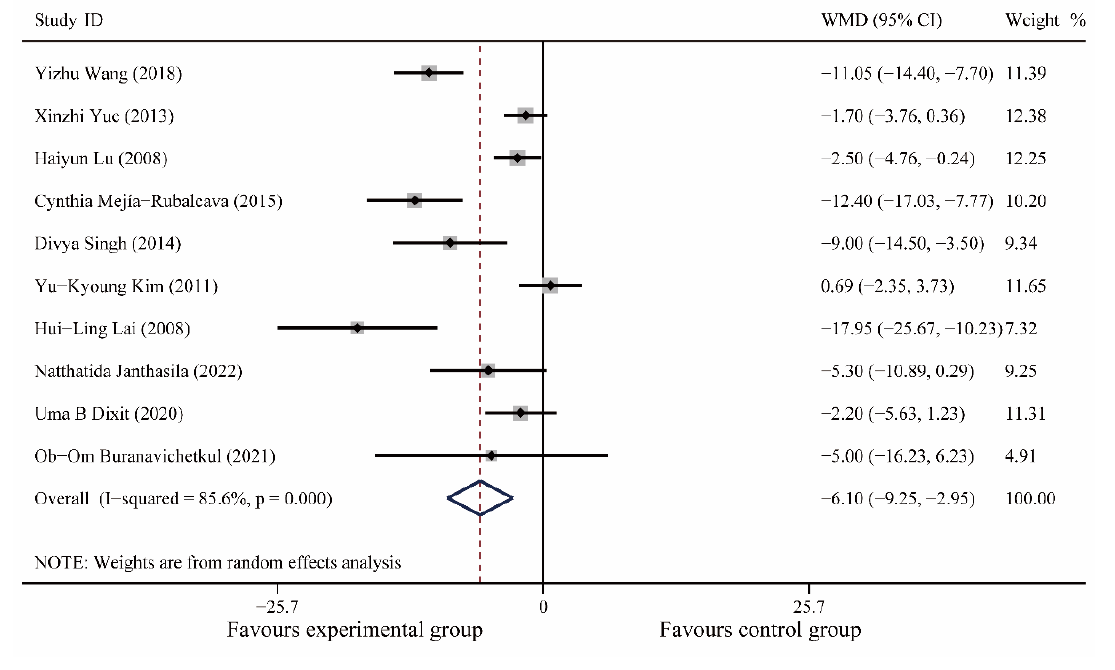
Figure 4. Forest plot of postoperative systolic blood pressure [20,21,24 – 27,29 – 31,34].